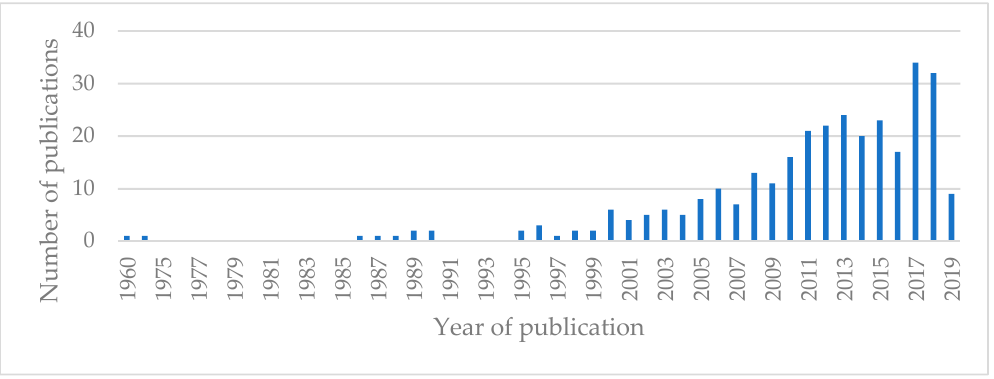
Figure 3. Number of publications analyzed according to publication year (based on publications used in the presented paper).